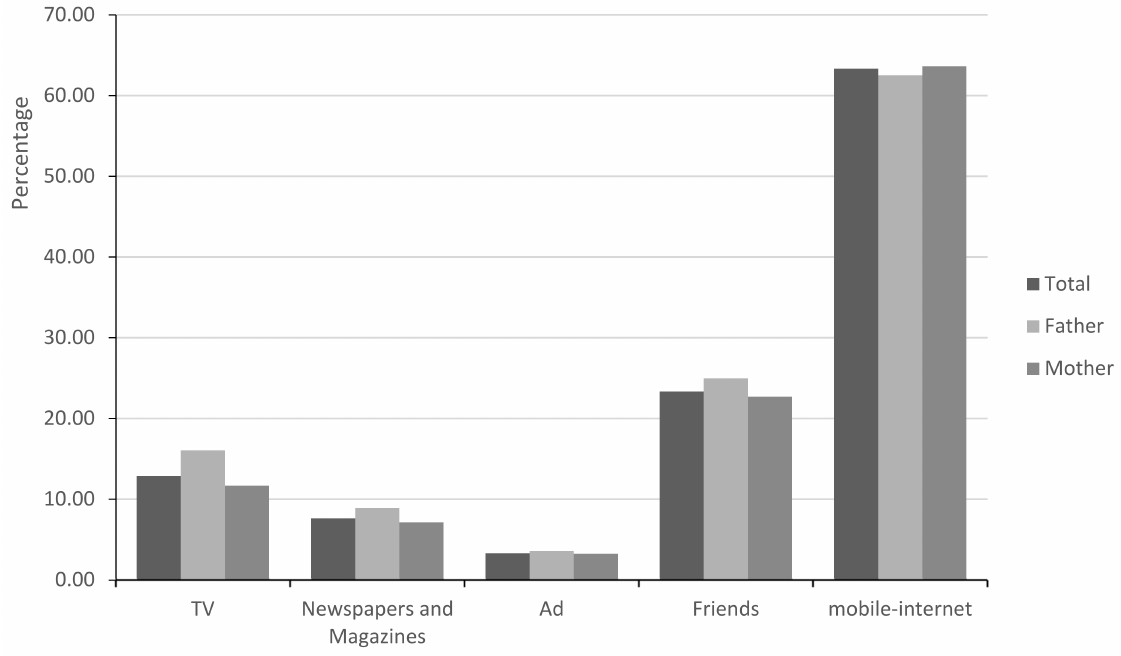
Figure 1. Sources of parents for accessing